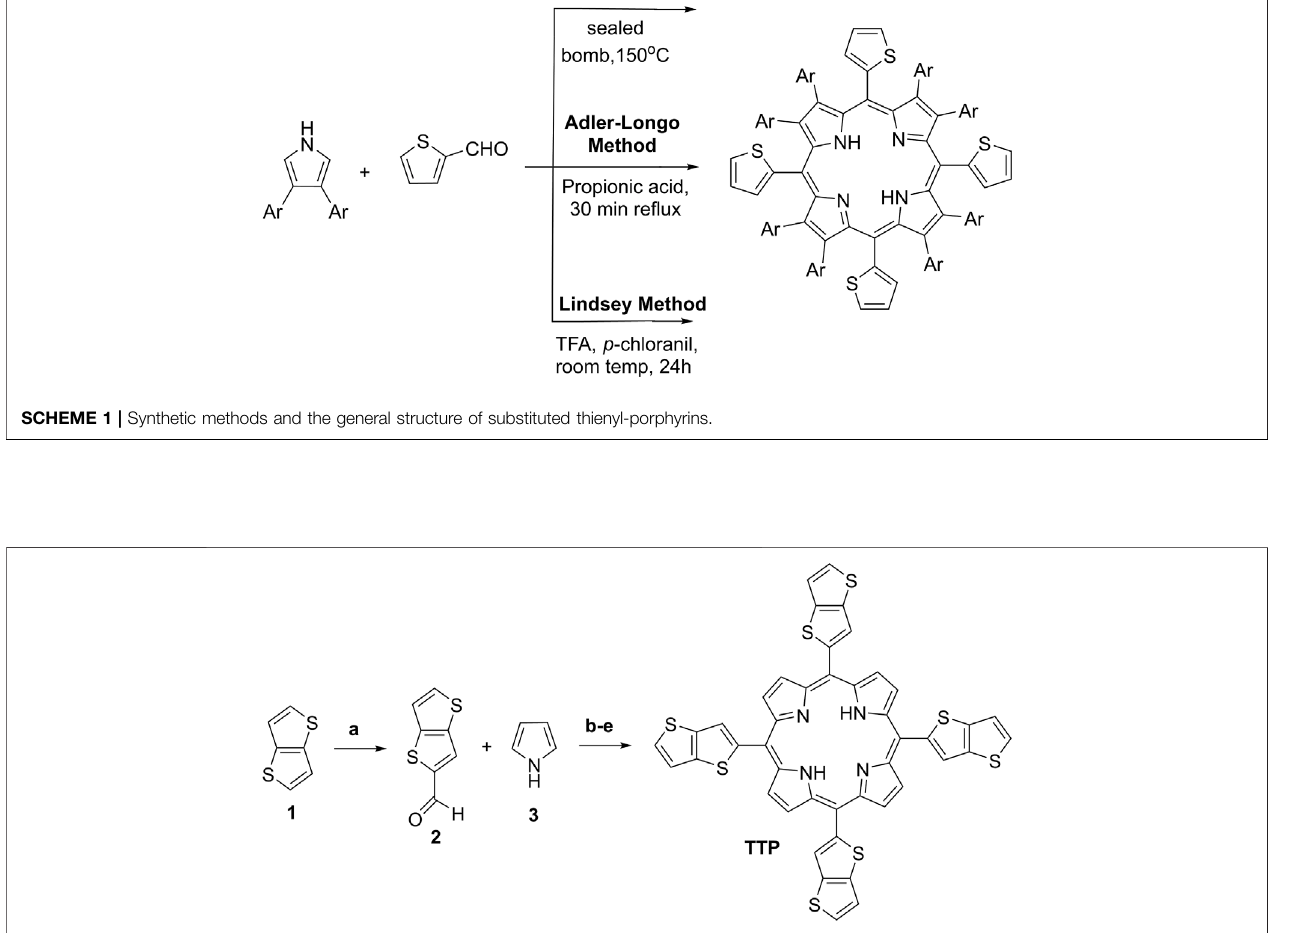
SCHEME 2 | Reaction conditions and yields: (A) Preparation of intermediate 2: 1, DMF, POCl3, 80 ° C, 2 h, and Yield: 81%; (B) Adler ’ s method procedure A: 2, 3, acetic acid,60 ° C,2 h, and Yield:2%; (C) Adler ’ smethod procedure B: 2,3, acetic acid, re fl ux30 min, and Yield: 2.4%; (D) Adler ’ smethod procedure C:2,